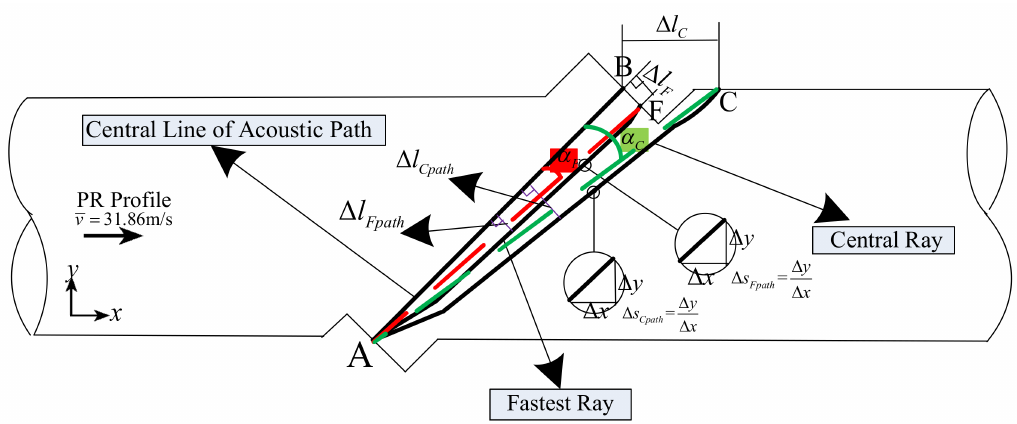
Figure 8. Sketch of the dimensionless parameter used in the ray result